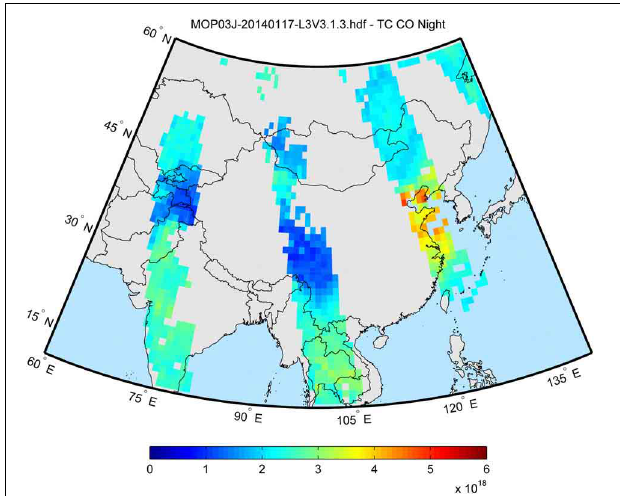
FIGURE 1 | Plot representing typical data gaps in satellite observations of tropospheric composition, illustrated using night-time total column carbon monoxide (CO) (units of molecules cm − 2 ) retrieved over Asia using data from the Measurements Of Pollution In The Troposphere (MOPITT) instrument on 17 January 2014. The figure shows both gaps between the swaths of the satellite platform as well as missing data points due to clouds and/or other measurement issues within each swath. Red colors indicate relatively high CO total column; blue colors indicate relatively low CO total column.